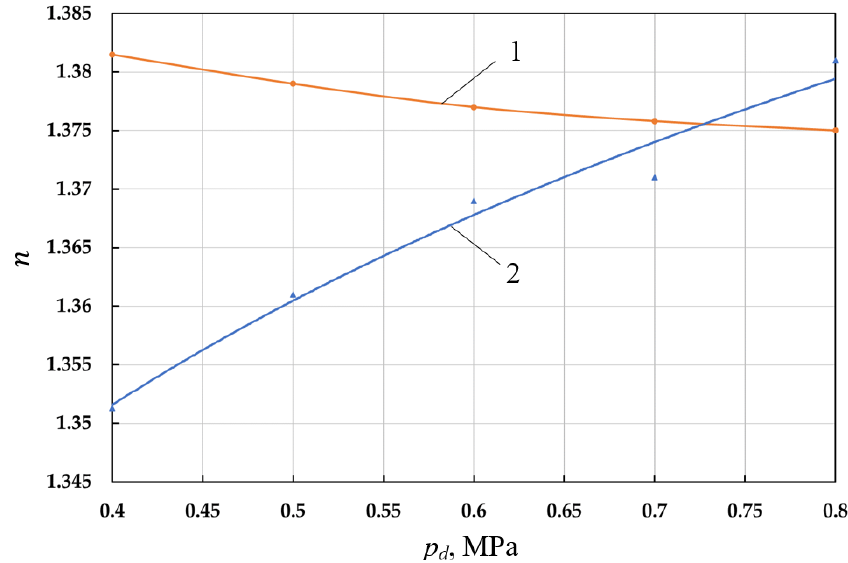
Figure 9. Dependence of the polytrope index of the final parameters of the compression process (1 — n cmp ) and the polytrope index of the final expansion parameters (2 — n exp ) on the discharge pressure.